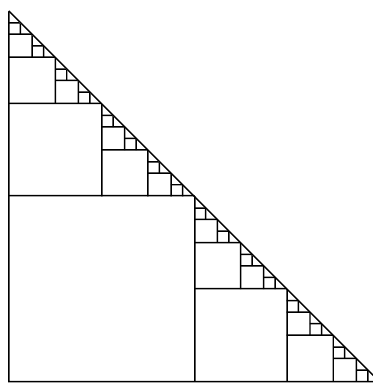
Figure 2: Hierarchical off-diagonal partioning of a lower triangular N × N matrix. The matrix is HODLR if the blocks in the recursive partitioning above, continued